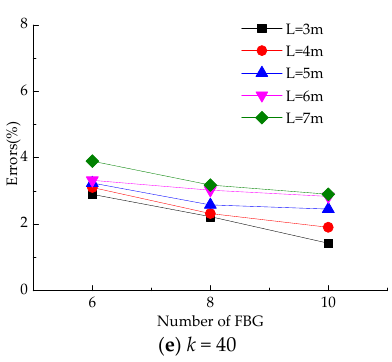
Figure 3. The relationship between the calculation error and the number of measurement points for different span lengths and span-to-height ratios. Table 1. The optimum number of measuring points.